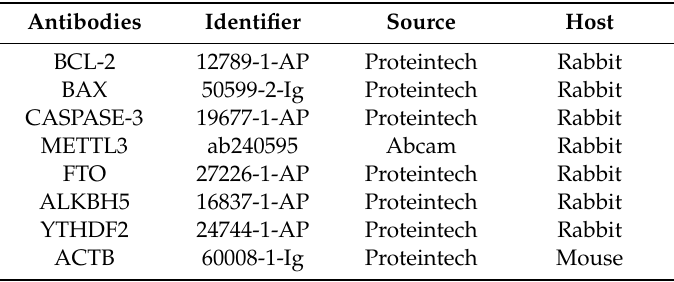
Table 2. The information of antibodies used in this